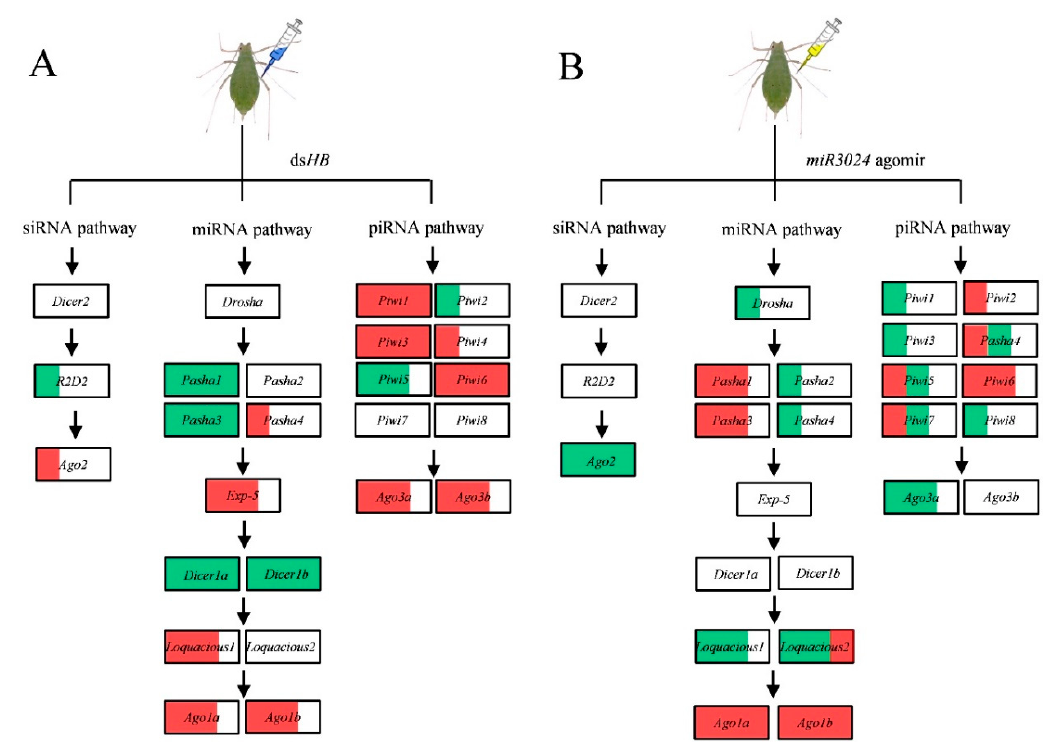
Figure 5. Schematic of expression profiles of core genes of three RNAi pathways upon dsRNA and miRNA agomir administration by microinjection. ( A ) ds HB treatment. ( B ) miR-3024 agomir treatment. The white, red, and green of the box represents the expression of gene are no significance, upregulation, and downregulation, respectively. 1/3, 2/3, and full red/green area of the box represent the ratio of genes upregulation/downregulation in three dose treatments of dsHB (6 ng, 60 ng, 600 ng) or miR-3024 agomir/antagomir (agomir: 15.4 ng, 23.1 ng, 30.8 ng; antagomir: 8 ng, 12 ng, 16 ng).